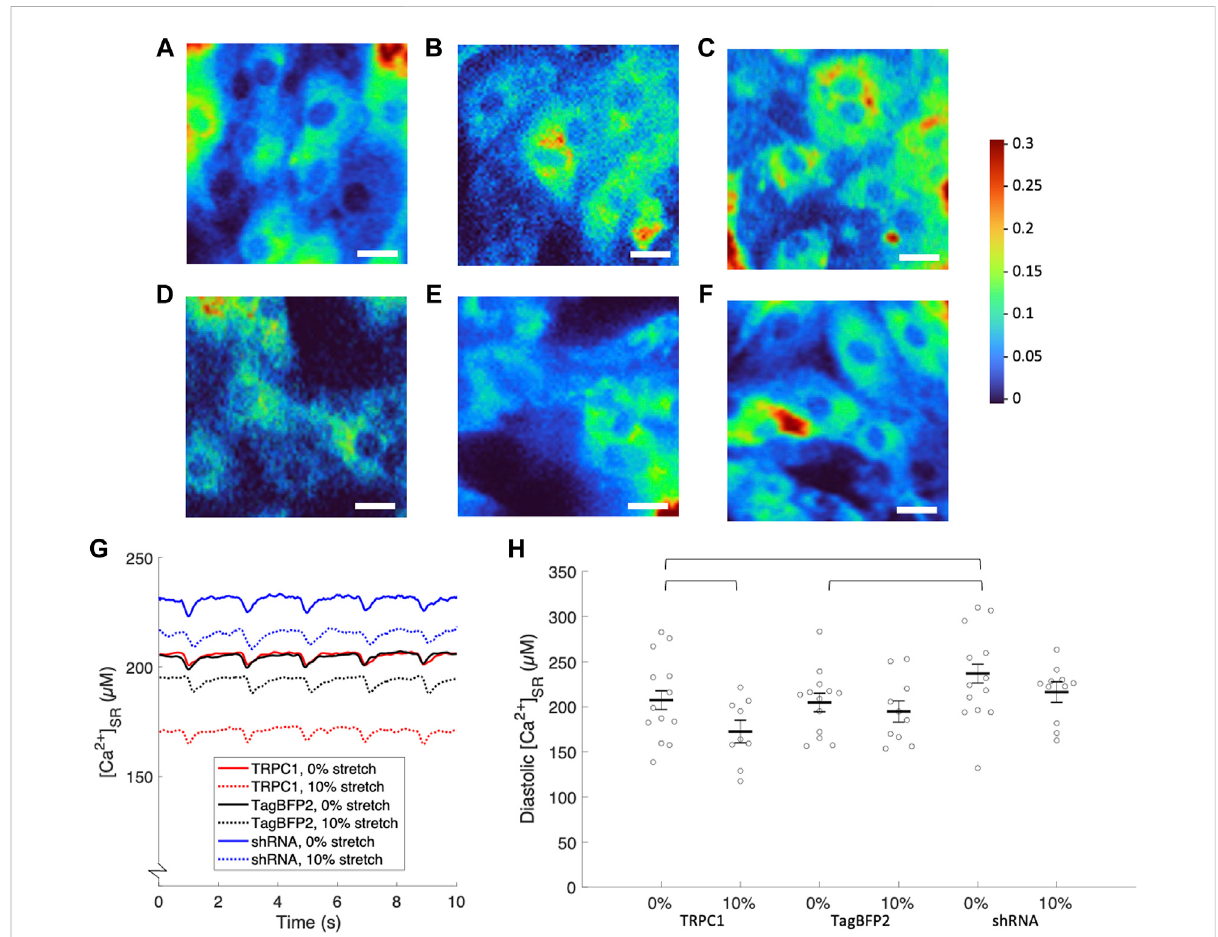
Calibrated[Ca 2+ ] SR from fl uorescentcalciumimagingofNRVMs.RepresentativeratiometricimagesoftheGCEPIAersignalovertheSNAPsignal in NRVMs infected with (A) TRPC1-TagBFP2 under 0% strain, (B) TagBFP2 under 0% strain, (C) shRNA-TRPC1-TagBFP2 under 0% strain, (D) TRPC1- TagBFP2 under10%strain, (E) TagBFP2 under 10%strain, and (F) shRNA-TRPC1-TagBFP2 under10%strain. Scalebars =20 µm. (G) Example[Ca 2+ ] SR transientsfromTRPC1-TagBFP2,TagBFP2andshRNA-TRPC1-TagBFP2infectedunstretchedandstretchedNRVMs. (H) Scatterplotofdiastolic [Ca 2+ ] SR ofeachinfectiongroupwith0or10%stretchaveragedbymembrane;pointscorrespondtotheaveragevalueofallcellsoneachmembrane and bars represent mean and SEM determined by multilevel mixed-effects model. Diastolic [Ca 2+ ] SR in unstretched NRVMs is signi fi cantly lower in TRPC1-TagBFP2 and TagBFP2 cells compared to shRNA-TRPC1-TagBFP2 cells. Sustained 10% stretch signi fi cantly lowered [Ca 2+ ] SR in TRPC1- TagBFP2 infected NRVMs. Brackets mark signi fi cant differences ( p < 0.05).